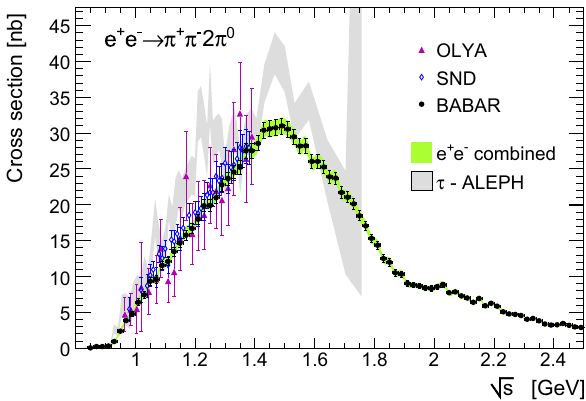
the HVPTools combinations within 1 σ uncertainties. The cross-section predictions within 1 σ uncertainties derived from ALEPH τ four-pion spectral functions are indicated by the light grey